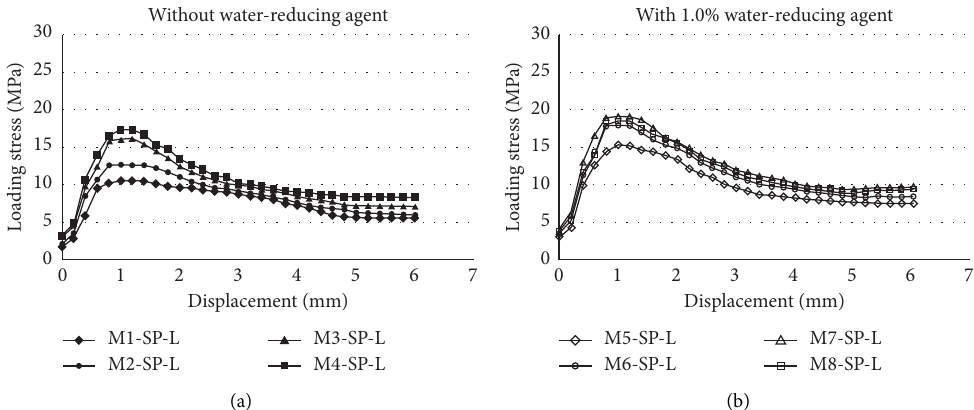
Figure 3: Relationship between loading stress and displacement with larger specimens: (a) without the water-reducing agent; (b) with 1.0% water-reducing